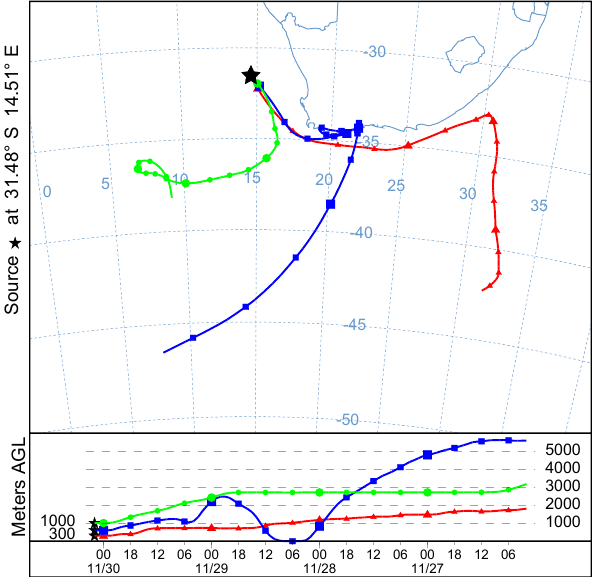
Figure 6. NOAA HYSPLIT backward trajectories for 4 days ending at the position of RV Polarstern (31.48 ◦ S, 14.51 ◦ E; marked by the black star) on 30 November 2015, 02:00UTC, at 300, 600, and